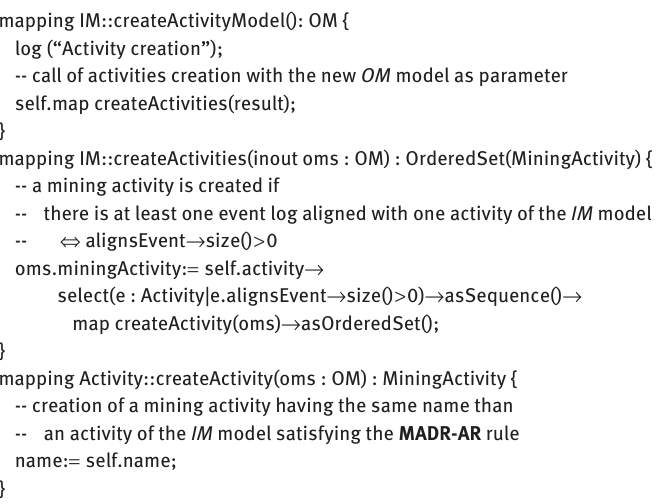
Algorithm 1: MADR-AR rule operational-QVT implementation (“--”: